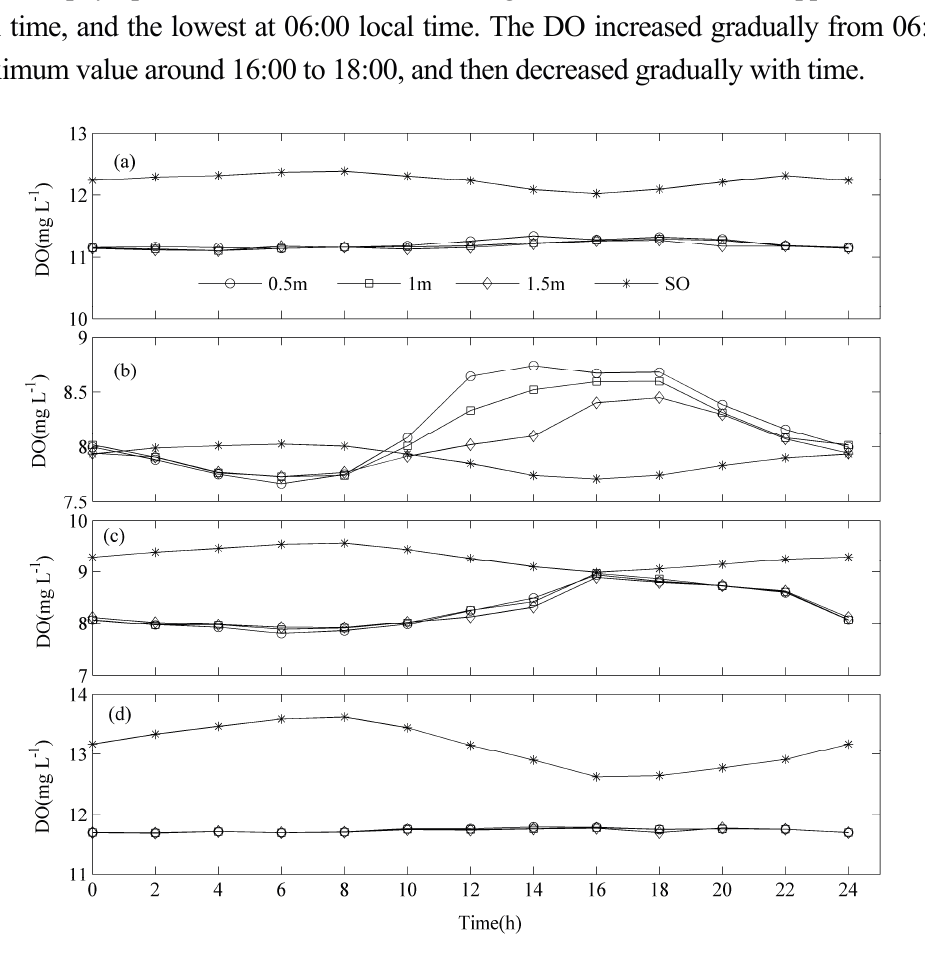
Figure 3. Seasonal changes in saturated oxygen (SO) and dissolved oxygen (DO) concentrations at different depths. ( a ), ( b ), ( c ), and ( d ) represent the variation in spring, summer, autumn, and winter,